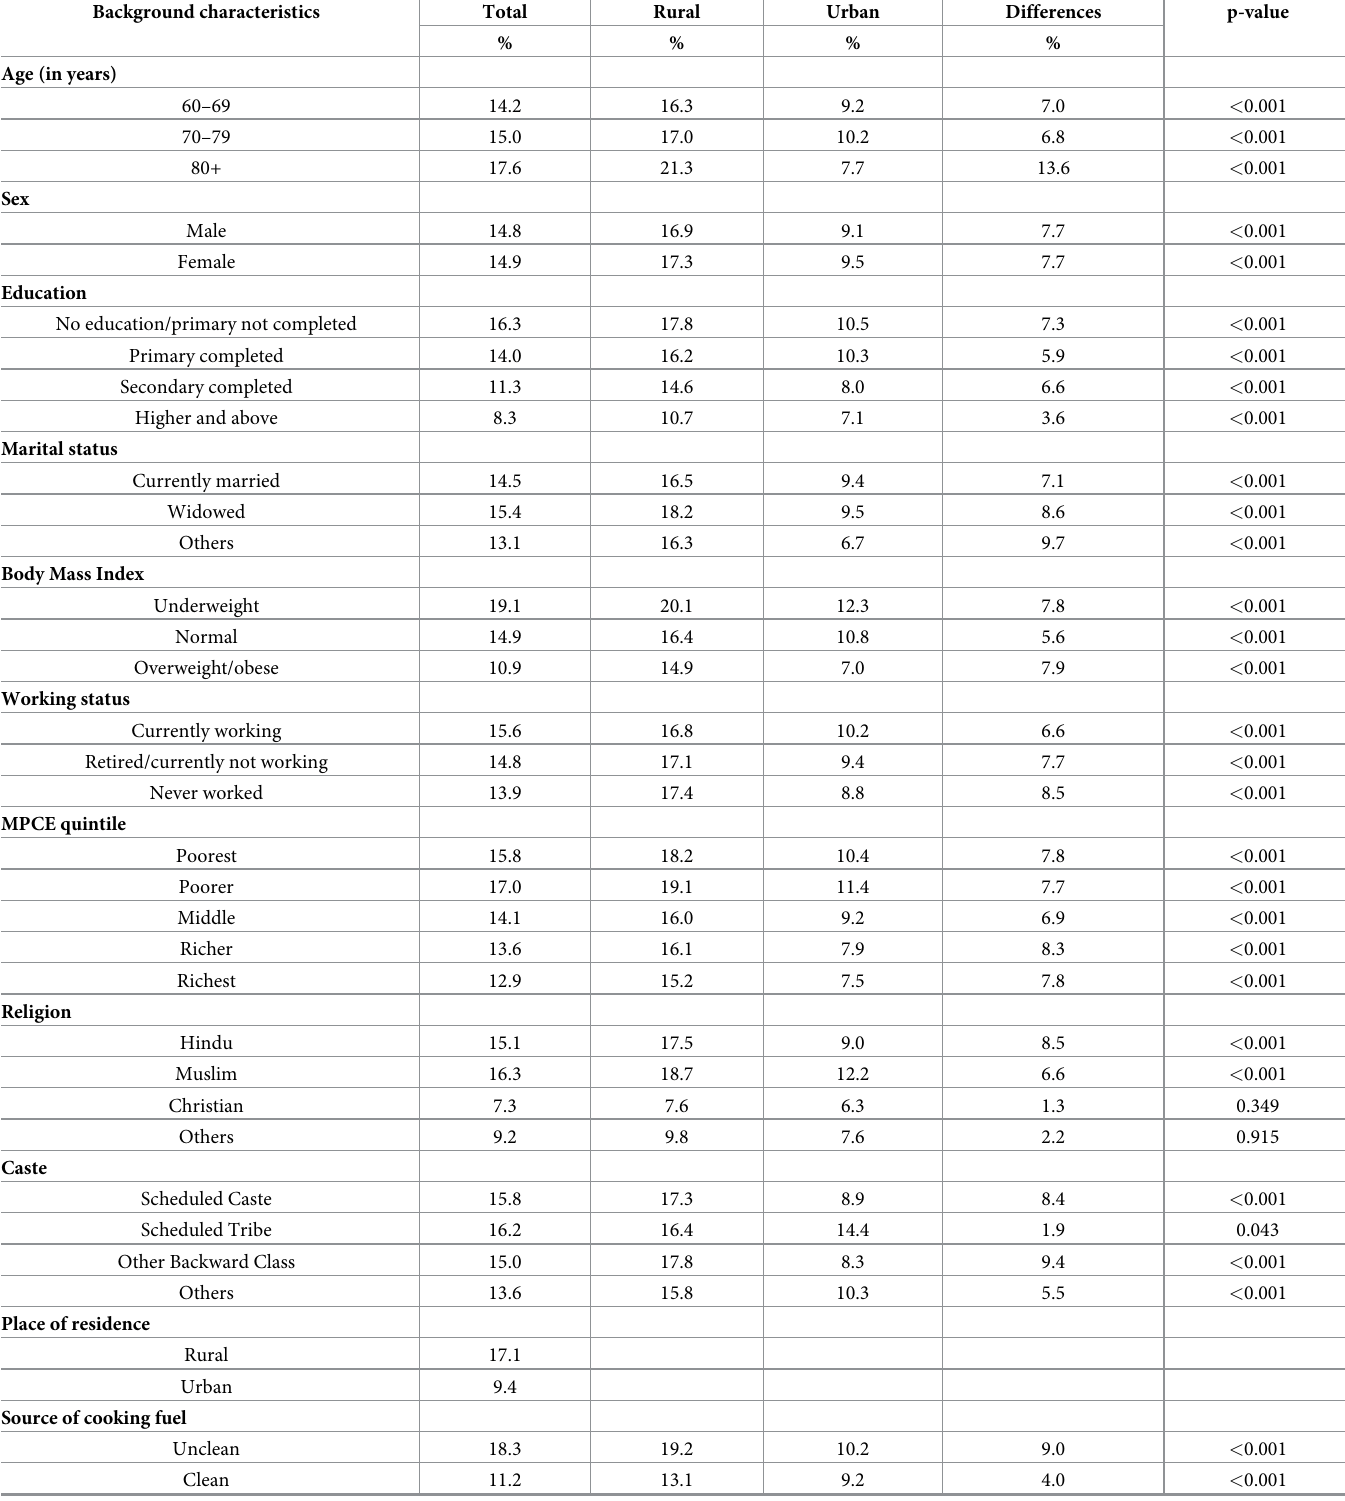
Table 3. Percentage of older adults suffering from diarrhoea by their background characteristics in India, 2017–18. Background characteristics Total Rural Urban Differences